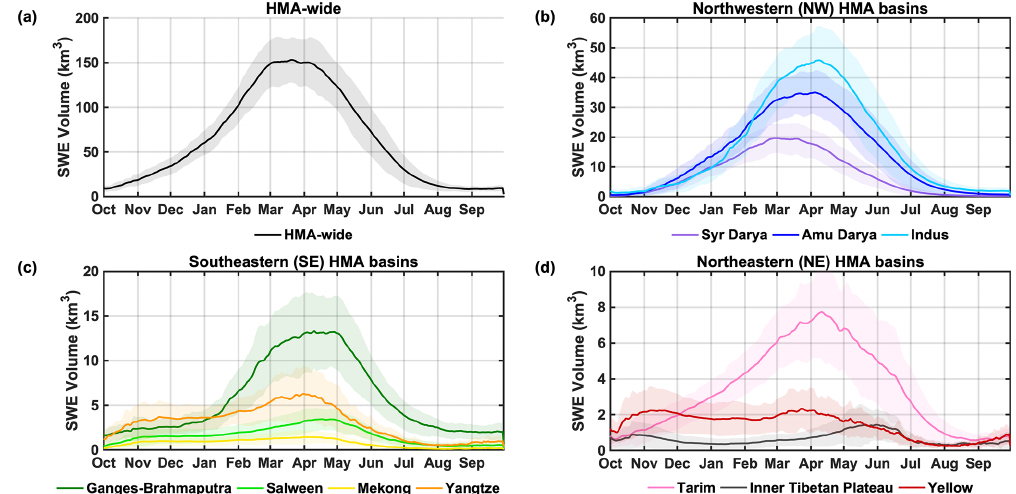
Figure 6. Climatological (18-year average; solid line) daily time series of seasonal SWE volumes, aggregated to (a) HMA-wide and basins in the (b) northwestern (NW), (c) southeastern (SE), and (d) northeastern (NE) subregions. The shaded area represents ± 1SD (standard deviation) around the climatological mean (i.e., representing a metric of interannual variation about the